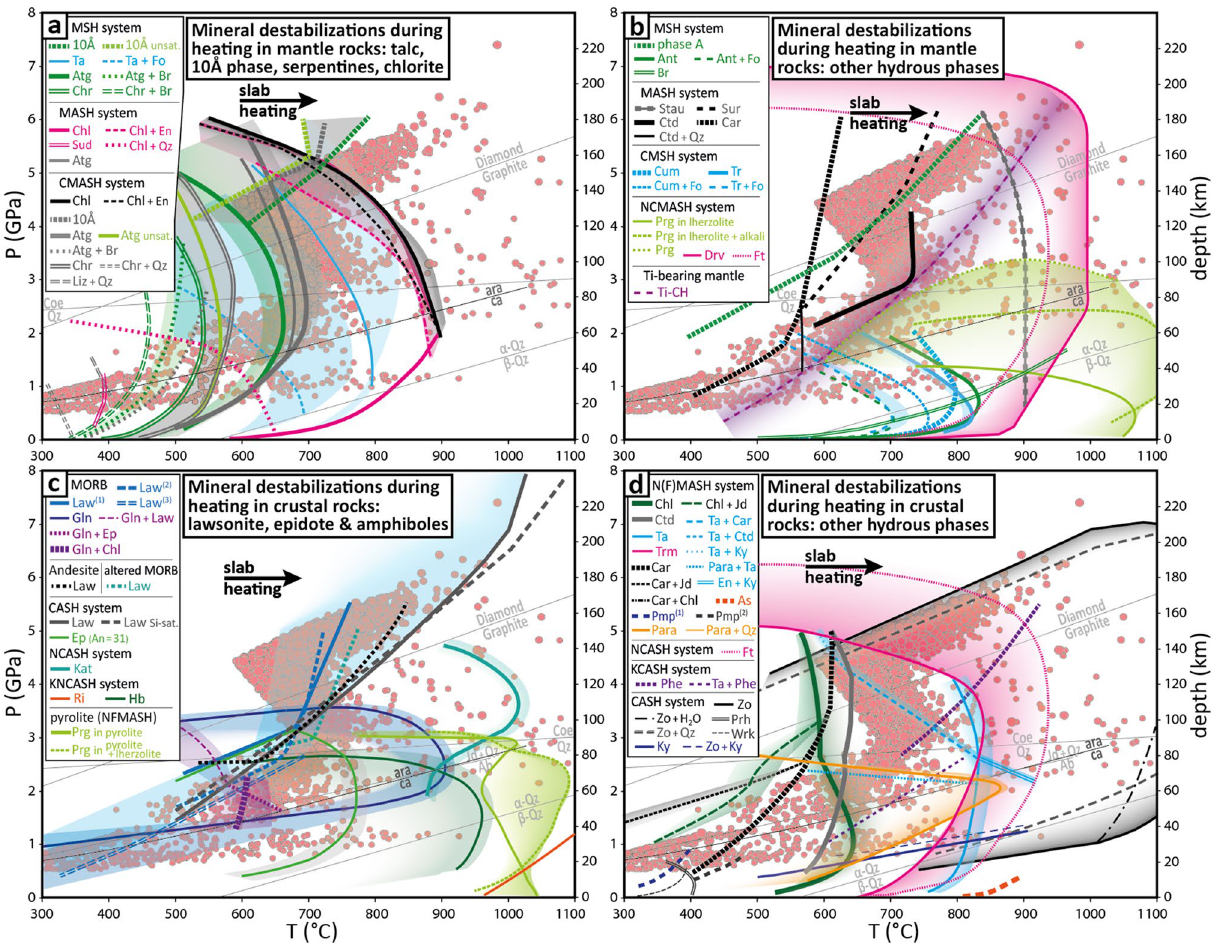
Figure 4. Vrancea deep seismicity and mineral destabilizations in the oceanic lithosphere. P–T conditions at hypocenters from 20 to 240 km depth compared to a review of mineral destabilizations in the mantle ( a , b ) and oceanic crust and subduction channel ( c-d ) during heating. For chemical formula and mineral reactions, see Table S1. Abbreviations: 10Å = 10-Å phase; A = phase A; Ab = albite; Ant = antophyllite; Atg = Antigorite; Ara = aragonite; As = aspidolite; Br = brucite; Ca = calcite; Car = carpholite; Ctd = chloritoid; Chl = chlorite; Chr = chrysotile; CH = clinohumite; Coe = coesite; Cum = cummingtonite; Drv = dravite; En = enstatite; Ep = epidote; Fo = forsterite; Ft: Mg-foitite; Gln = glaucophane; Hb = Hornblende; Jd = jadeite; Kat = Mg-Katophorite; Ky = kyanite; Law = lawsonite; Lz = lizardite; Para = paragonite; Phe = phengite; Phl = phlogopite; Pmp = pumpellyite; Prg = pargasite; Prh = prehnite; Qtz = quartz; Ri = K-richterite; Stau = staurolite; Sud = sudoite; Sur = Mg-sursassite; Ta = talc; Tr = tremolite; Trm = tourmaline; Wrk = Wairakite; Zo = zoisite. Chemical systems: MORB = Mid-Oceanic-Ridge Basalt; K = K 2 O; N = NaO; M = MgO; A = Al 2 O 3 ; C = CaO; S = SiO 2 ; H = H 2 O; F = OF 2 . Phases formula and references are presented in Table